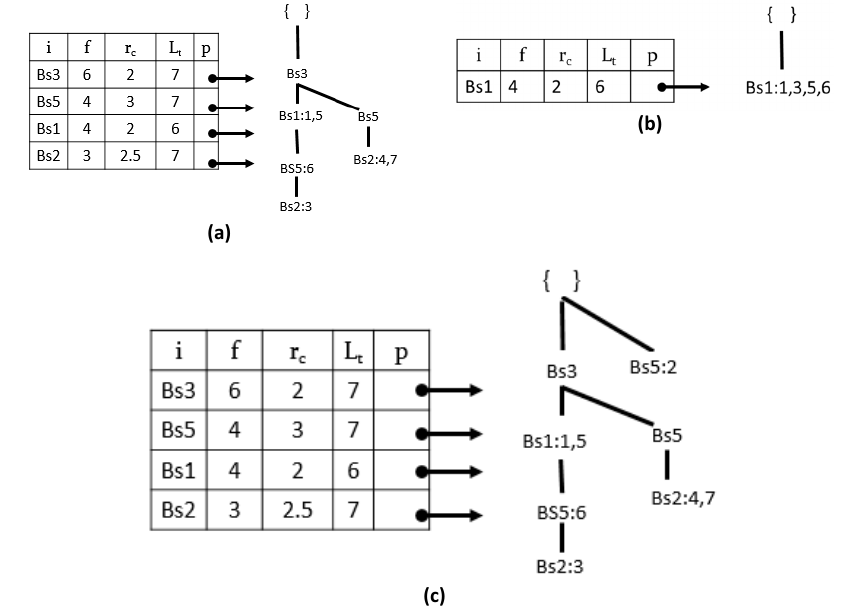
13 of 20 Algorithm 3: PPFP-growth (tree, α ). 1: for each sensor S α in the header of Tree in reverse-order do 2: